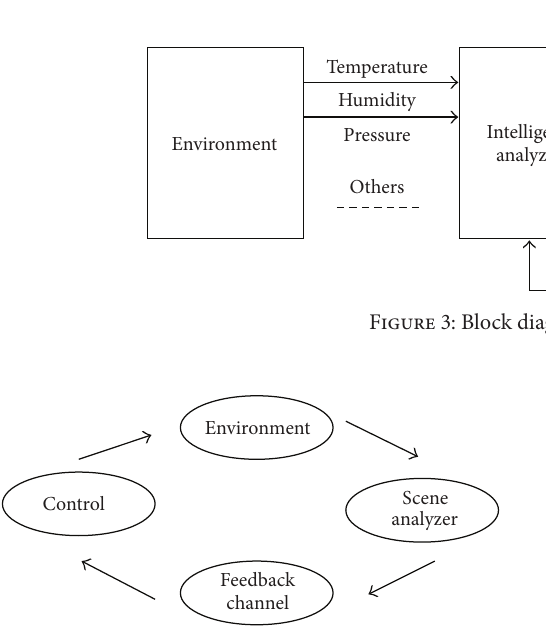
Figure 2: Block diagram of cognitive radar.